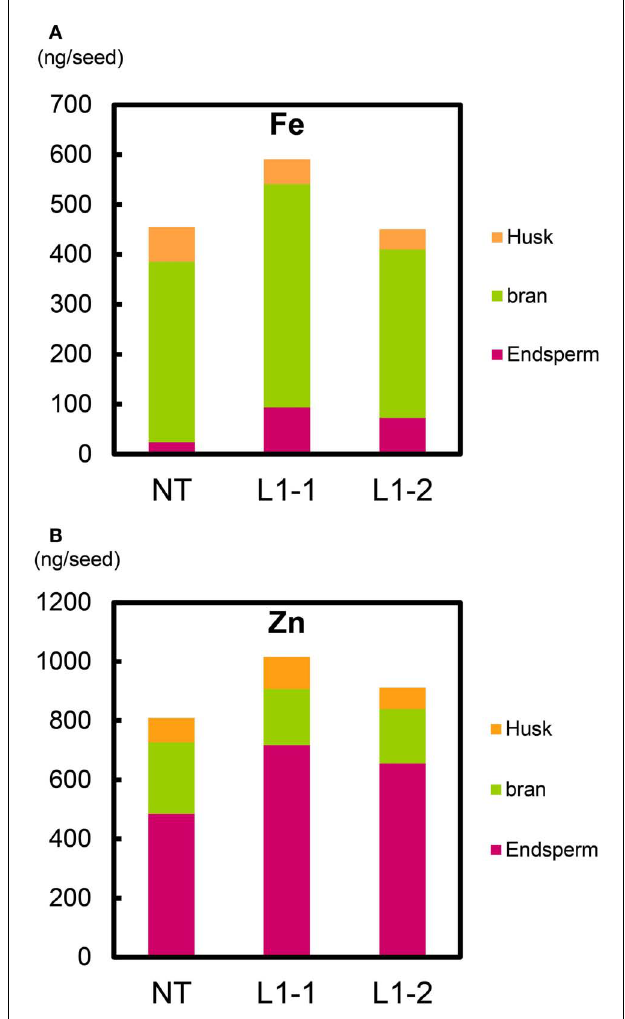
FIGURE 11 | Fe and Zn content perT 2 seed of Paw San Yin-Fer-NAS-YSL2 . (A) Fe content in husk, bran, and endosperm perT 2 seed. (B) Zn content in husk, bran, and endosperm perT 2 seed. NT, non-transgenic Paw SanYin; L1-1 and L1-2, Paw SanYin-Fer-NAS-YSL2 transgenic line 1 sublines. Metal content of polished seed is shown as endosperm. Metal content of bran is calculated by subtracting metal content of polished seed from that of brown